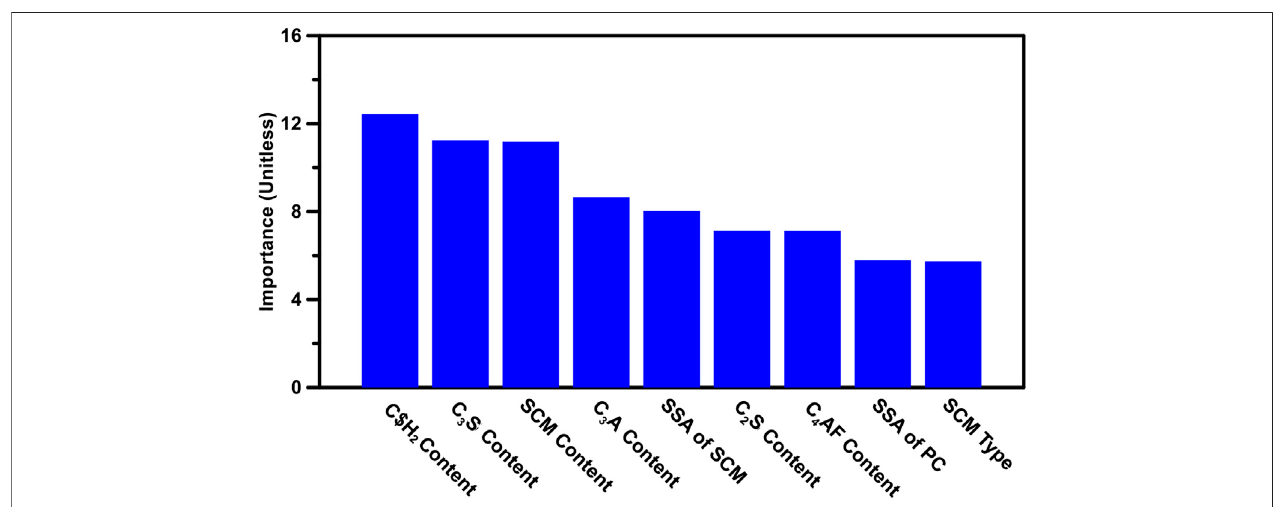
FIGURE 8 | Ranking of input variables (descending order of variable importance), based on their abilities to in fl uence the 24-h cumulative release of (PC + SCM) pastes at 24 h.